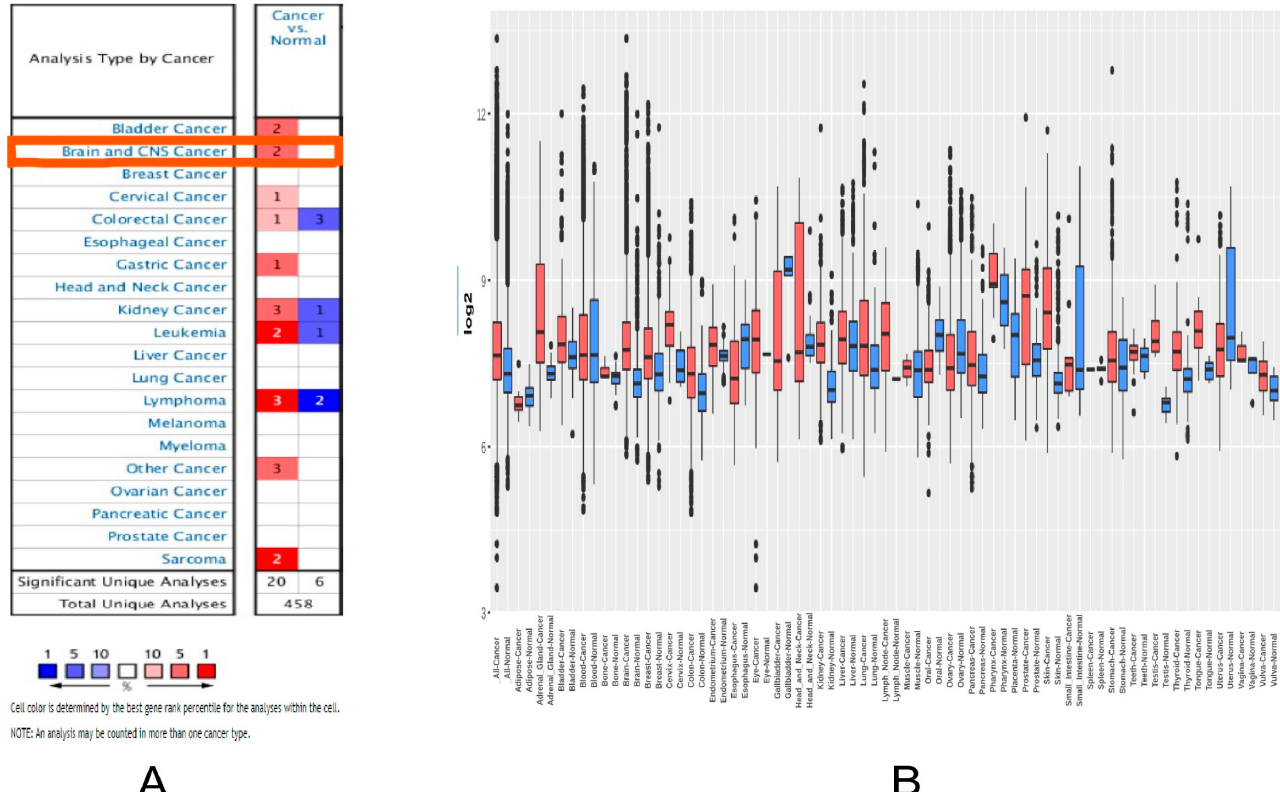
Figure 1. The expression profile of the MDM2 gene mRNA in a variety of cancer types. ( A ) The mRNA expression of MDM2 in various malignancies from the Oncomine database, with red cells denoting datasets with strong mRNA upregulation and blue cells denoting datasets with notable mRNA downregulation. ( B ) Analysis of MDM2 gene pan-cancer expression profiles from the TIMER database in dot plot where each dot represents different sampling expression. The expression of mRNA in different cancer types is measured in transcripts per million